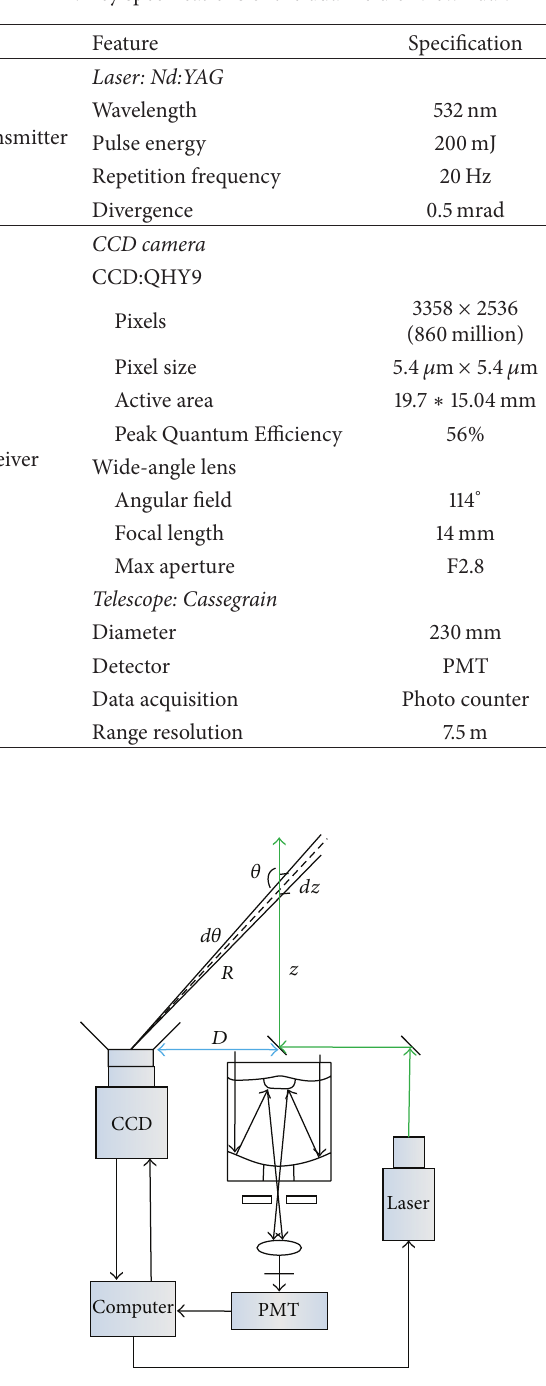
the resolution and reduce the noise. The FOV of the receiver which consists of a CCD and a wide-angle lens is about 75.4 ∘ .